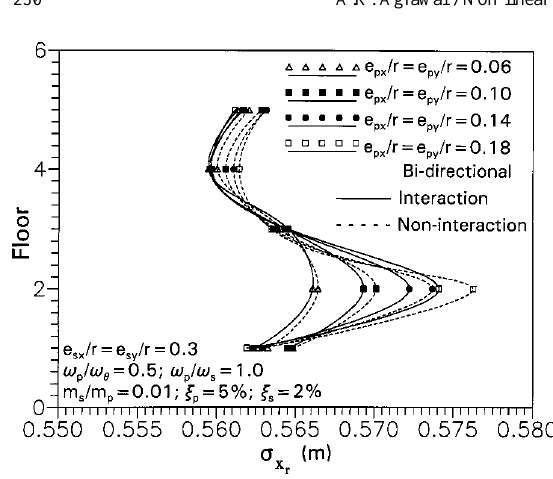
Fig. 6. Variation of (cid:27) x with storey height for various values of r e p x =r and e p y =r ; for m s =m p = 0.01; ! p =! s = 1.5; ! p =! (cid:18) = 1.0; e